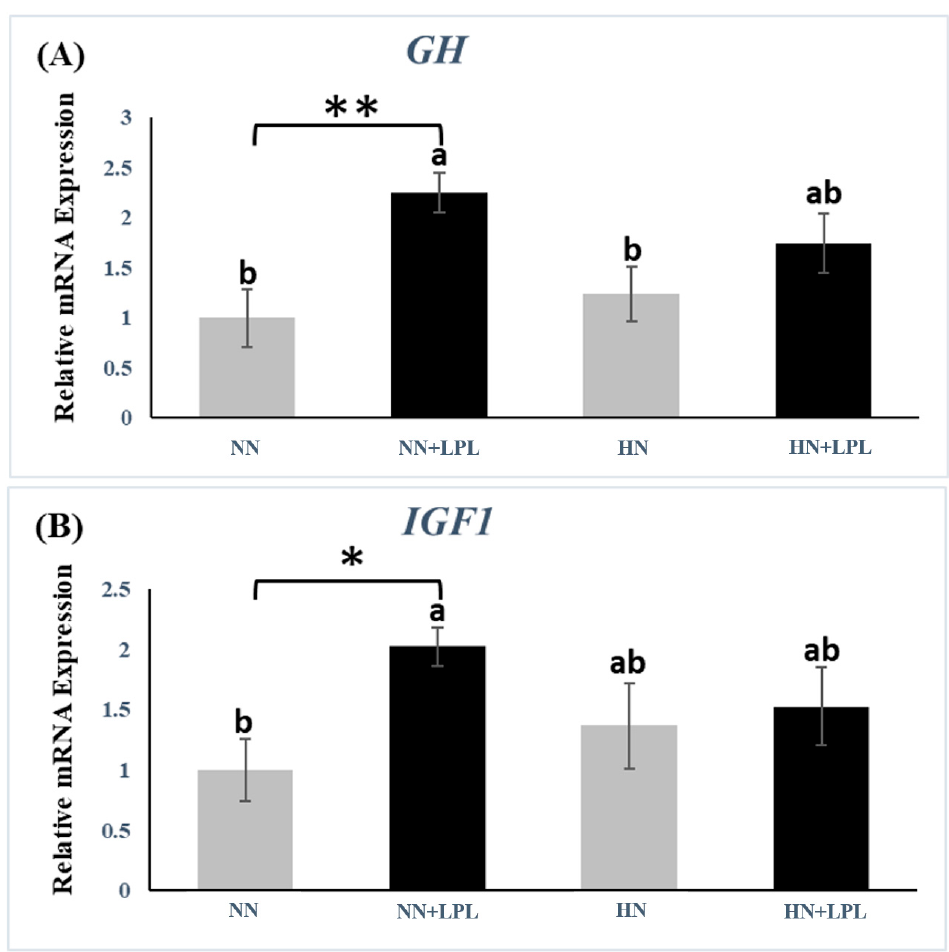
Figure 1. Quantitative genes expression of growth-related genes in liver following LPL supplementation. (A) The gene expression of GH. (B) The gene expression of IGF1. Significant differences between basal diet and diet with LPL supplementation groups are indicated by * p < 0.05 and ** p < 0.01. a,b Bars with no common letter differ significantly ( p < 0.05). Error bars indicate the standard error of the mean. IGF, insulin-like growth factor 1; GH, growth hormone. Abbreviation: NN, Normal nutrition diet; NN + LPL, NN + 500 g/t of LPL; HN, NN + 0.5% CP and 50 Kcal/kg; HN + LPL, HN + 500 g/t LPL.